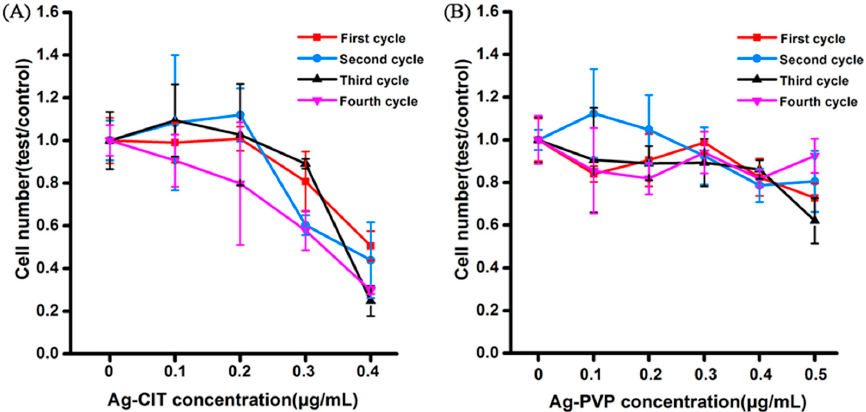
Figure 8. Proliferation of Caco-2 cells after exposed to three Ag NPs. Cells had been repeatedly exposed to Ag-CIT and Ag-PVP for 4 cycles and counted after each exposure circle, along with corresponding untreated controls. ( A ) Ag-CIT; ( B ) Ag-PVP. Three parallel well were set for each sample and cells in each well were counted three times.